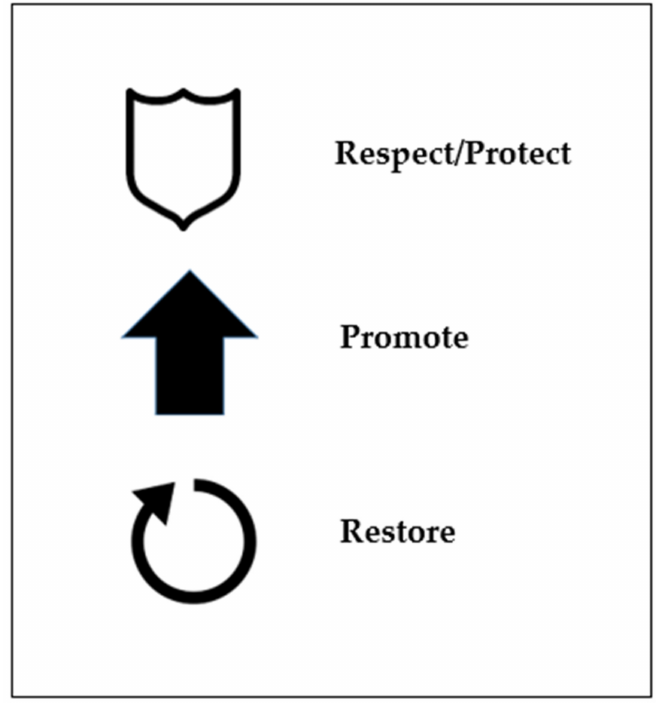
Figure 1. Democratic land